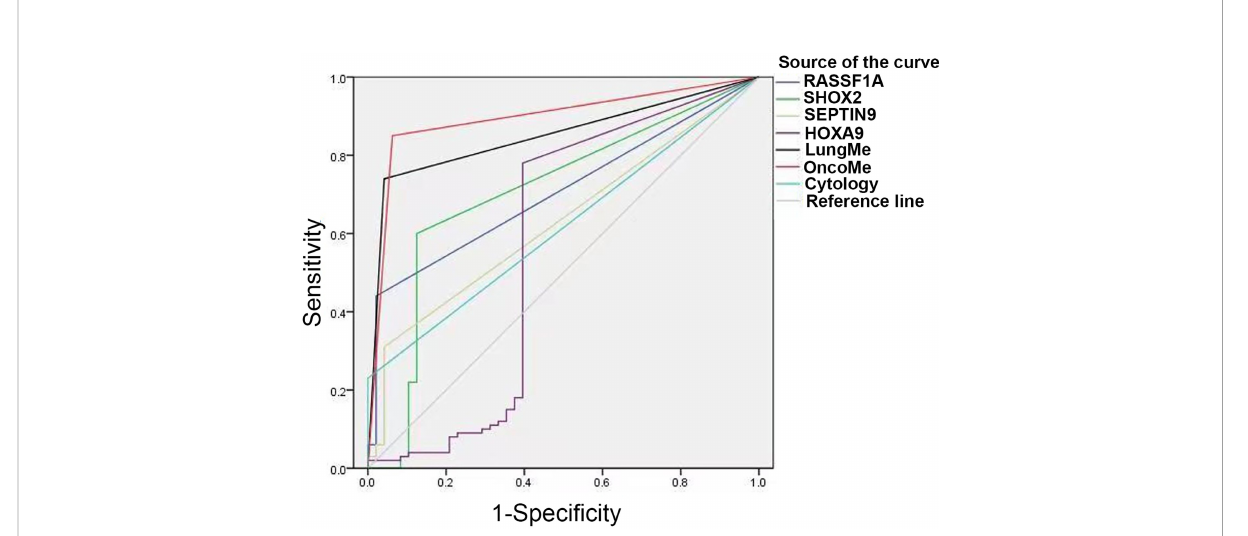
FIGURE 5 ROC curves for cytology, SHOX2, RASSF1A, SEPTIN9, HOXA9 and the LungMe ® and OncoMe methylation panels. SHOX2, short stature homeobox gene two; RASSF1A, RAS association domain family 1, isoform A; HOXA9, homeobox A9; SEPTIN9, Septin 9.